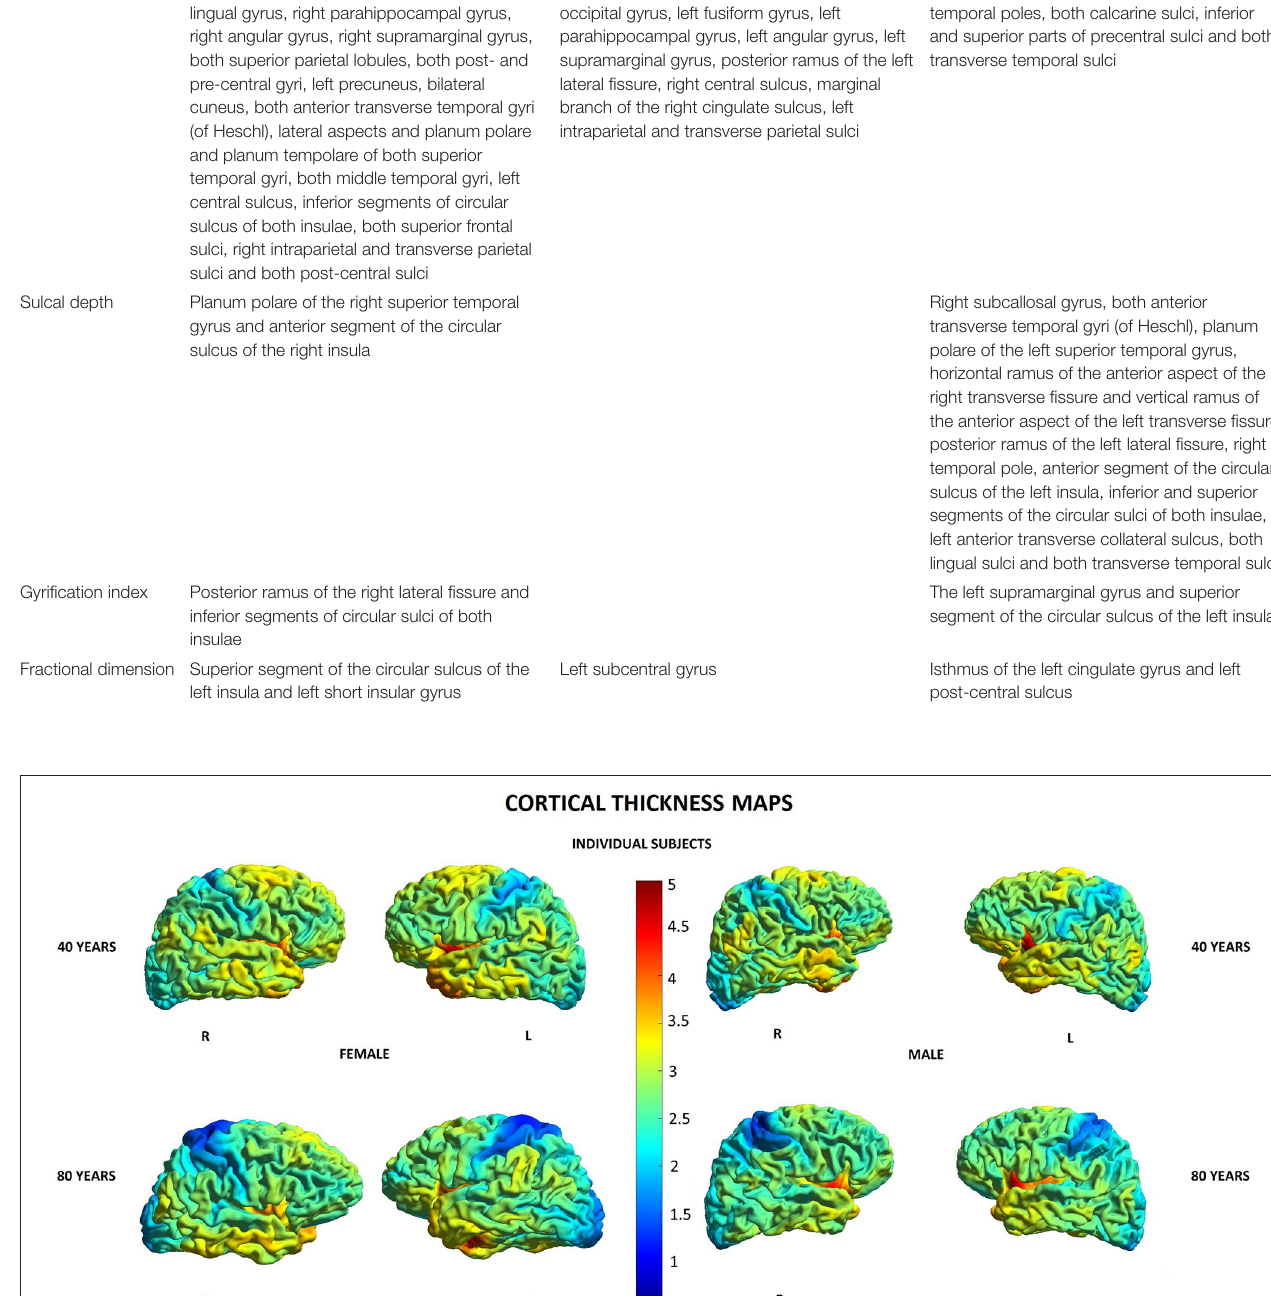
Frontiers in Neurology |